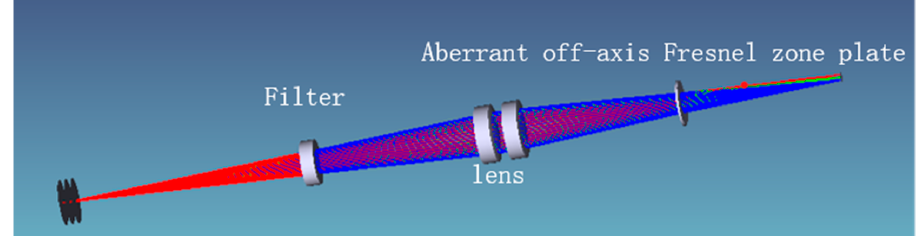
Figure 3. Simulation light path diagram of 3D microscopic imaging system.